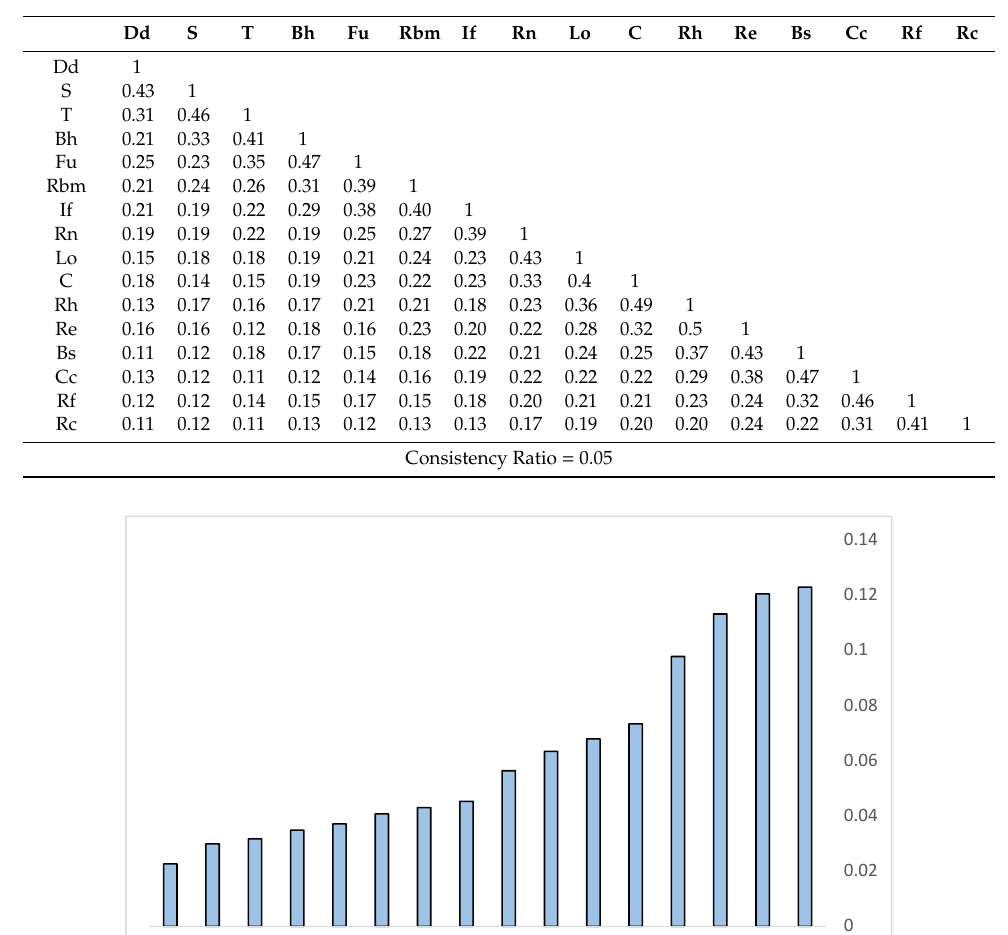
Table 7. Final weight of sub ‐ basins using complex proportional assessment of alternatives (COPRAS) models.